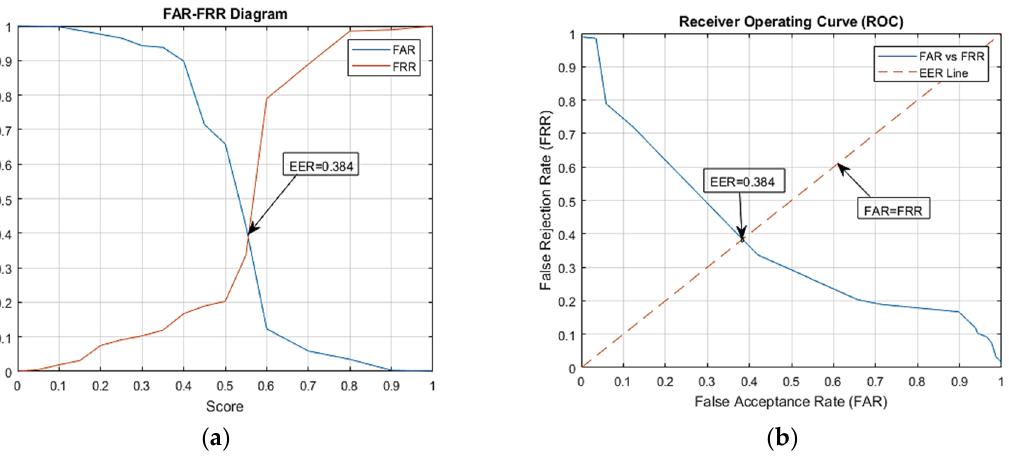
Figure 13. Performance graph for PCA-based method. ( a ) % Error for threshold distance. ( b ) ROC curve.